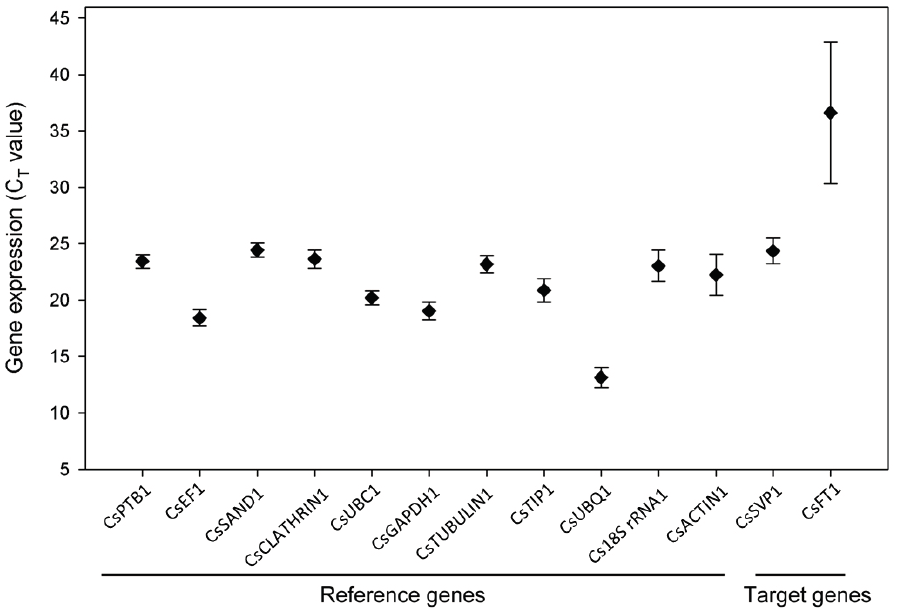
Figure 1. Average cycle threshold ( C T ) values for 11 candidate reference genes. The filled diamond symbol indicates the mean of C T values. The bars indicate standard